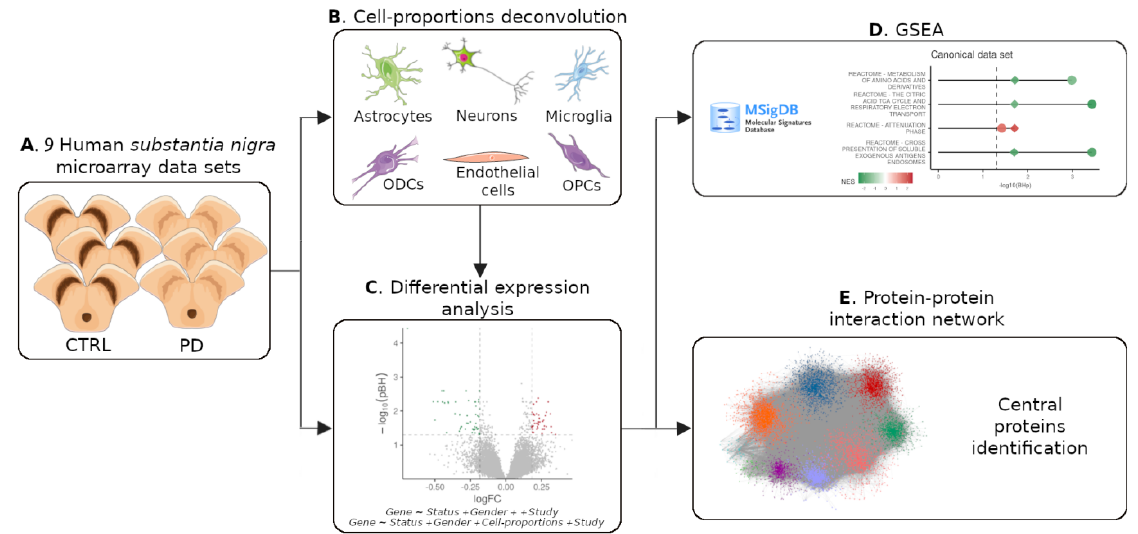
Figure 1. Summary of this study. ( A ) Human substantia nigra microarrays from PD and CTRL were downloaded from GEO. ( B ) Cell-proportion deconvolution for six cell types. ( C ) Differential expression analysis with and without cell proportions. ( D ) GSEA on the expression matrix. ( E ) Central protein identification in PPI network around detected differentially expressed genes. Drawings of substantia nigra and cells were obtained from Servier Medical Art templates (Creative Commons Attribution 3.0 Unported License; https://smart.servier.com accessed on 1 May 2021).